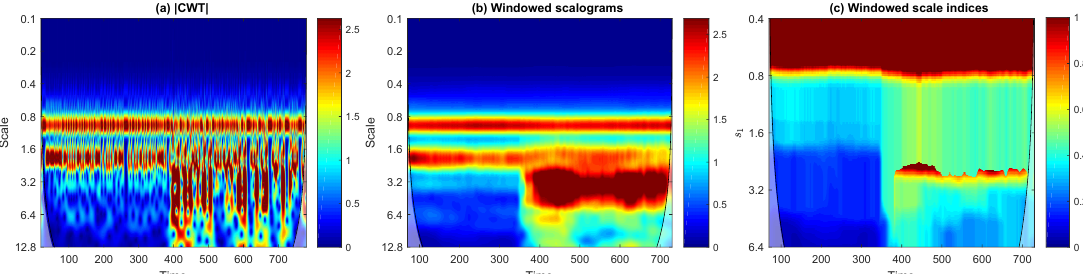
Figure 6. Different stages for obtaining the windowed scale indices of series 3. ( a ) Moduli of the CWT. ( b ) Windowed scalograms centered at different times with time radius τ = 50. ( c ) Windowed scale indices centered at different times with time radius τ = 50, taking s 0 = 0.05 and different values of s 1 from 0.4 to 6.4. The cone of influence outside which there are border effects is also represented with a black line in all